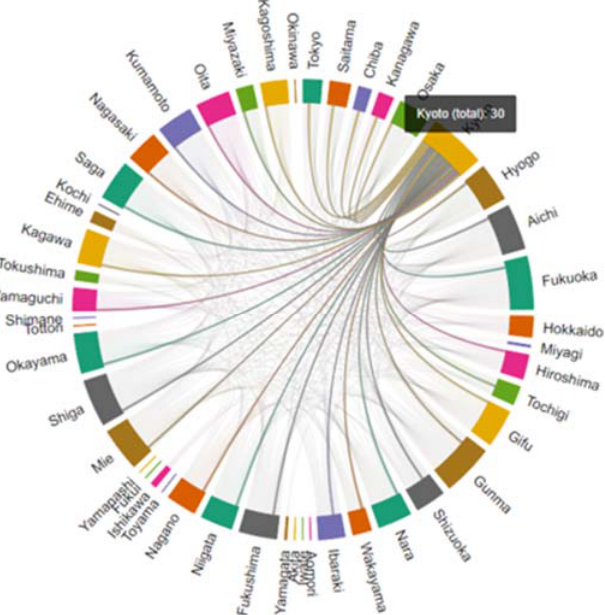
Figure 6. Schematic representation of the COVID-19 pandemic diffusion graph for Kyoto. Nodes (prefectures) are represented in color and the virus-spreading pattern in Kyoto is indicated with lines.